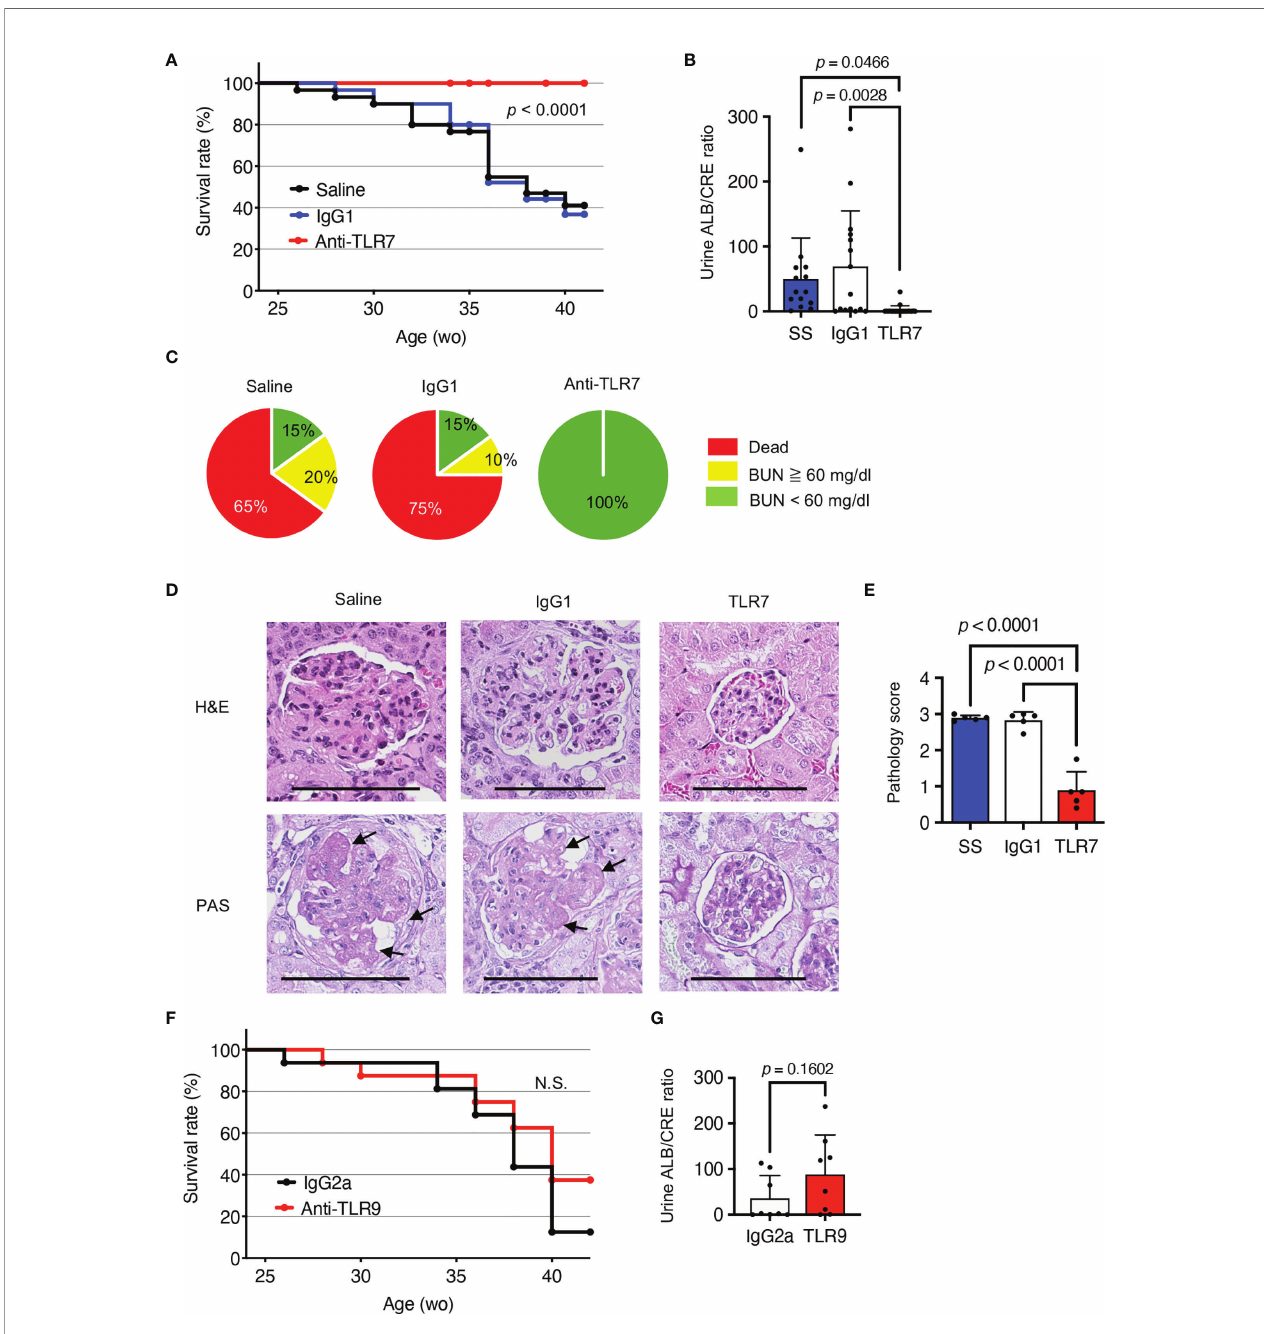
FIGURE 1 | Protective effects of anti-TLR7 mAb against lupus nephritis. (A-E) NZBWF1 mice were intraperitoneally administered 10 mg/kg of anti-TLR7 mAb (clone A94B10, IgG1), isotype control (clone TF904, IgG1) mAb or standard saline (control) weekly from age 12-16, until 35-40 weeks. (A) Survival of NZBWF1 mice ( n = 30 per group). (B) Urinary albumin (ALB)/creatinine (CRE) ratio in 30-40-week-old NZBWF1 mice ( n = 30). (C) Ratios (%) of mice with blood urea nitrogen (BUN) above (yellow) or below (green) 60 mg/dL at age of 40 weeks and those of dead mice (red; n = 20). (D) Representative images of glomerular sections visualized by hematoxylin and eosin (HE) or periodic acid-Schiff (PAS) staining. Arrows, increased numbers of mesangial cells. Scale bar, 100 m m. (E) Pathology scores from 0 to 3 ( n = 5). (F, G) NZBWF1 mice were administered anti-TLR9 mAb (clone NaR9, IgG2a, n = 16) or isotype control mAb (clone YN907, IgG2a, n = 16) at 10 mg/kg from age 12-40 weeks. (F) Survival curves of mice administered Ab ( n = 16). (G) Urinary ALB/CREA ratio in mice aged 30-40 weeks ( n = 8). Data were statistically analyzed using Log-rank tests (A, F) , one-way ANOVA with Tukey ’ s multiple comparison tests (B, E) , or Student ’ s t -tests (G) . Data are shown as individual points and as means ± SD for each experimental group (B, E, G)